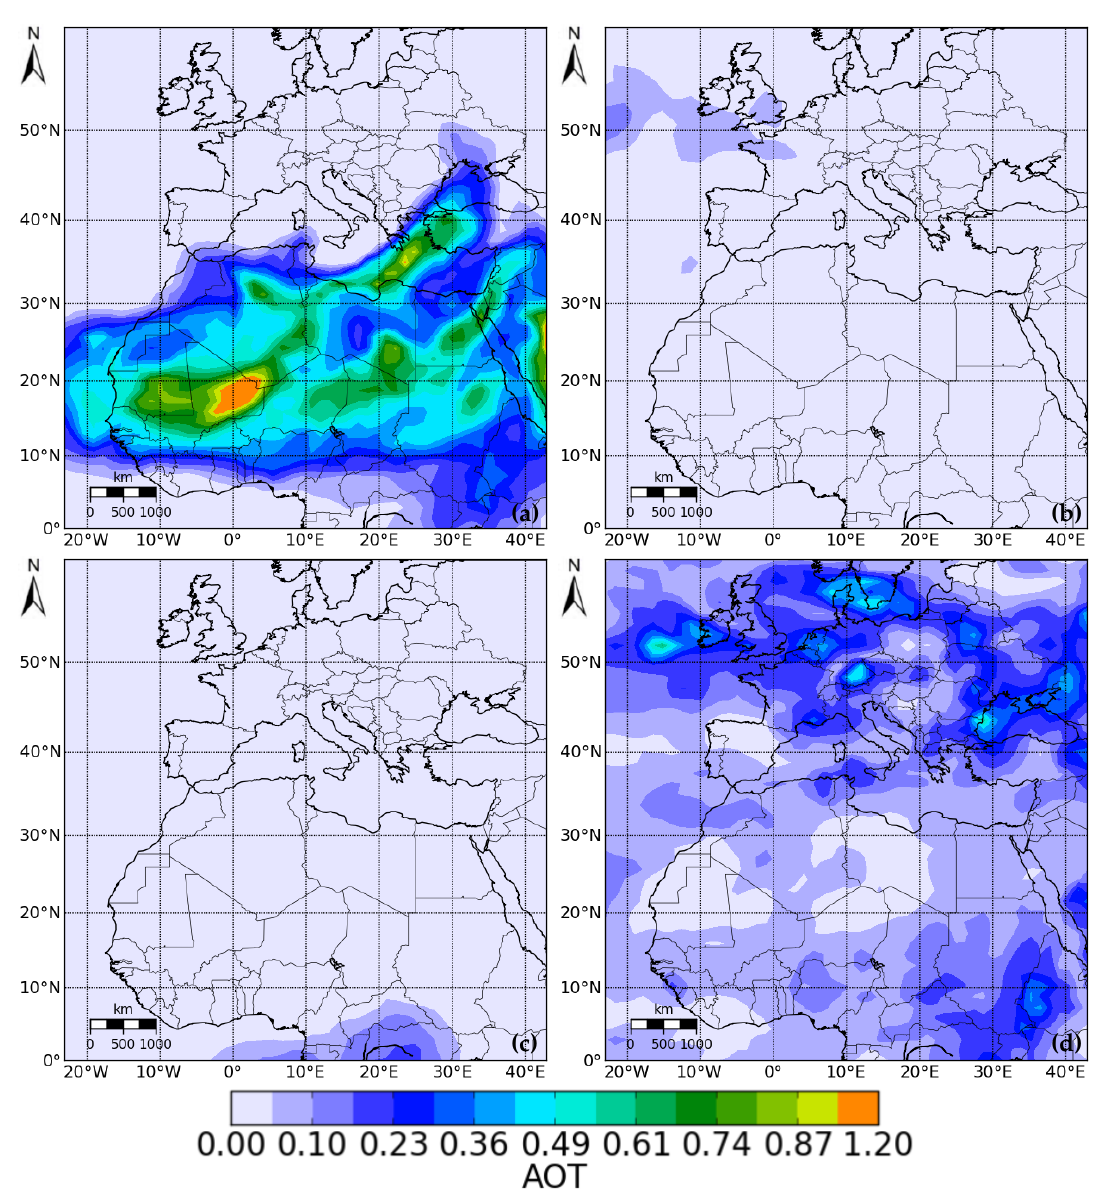
Figure 1. Copernicus Atmosphere Monitoring Service (CAMS) aerosol optical thickness forecasts at 550 nm on 14 June 2016, 03:00 UTC (Coordinated Universal Time): ( a ) Dust, ( b ) Sea Salt, ( c ) Black Carbon, and ( d ) Sulfate. AOT: aerosol optical